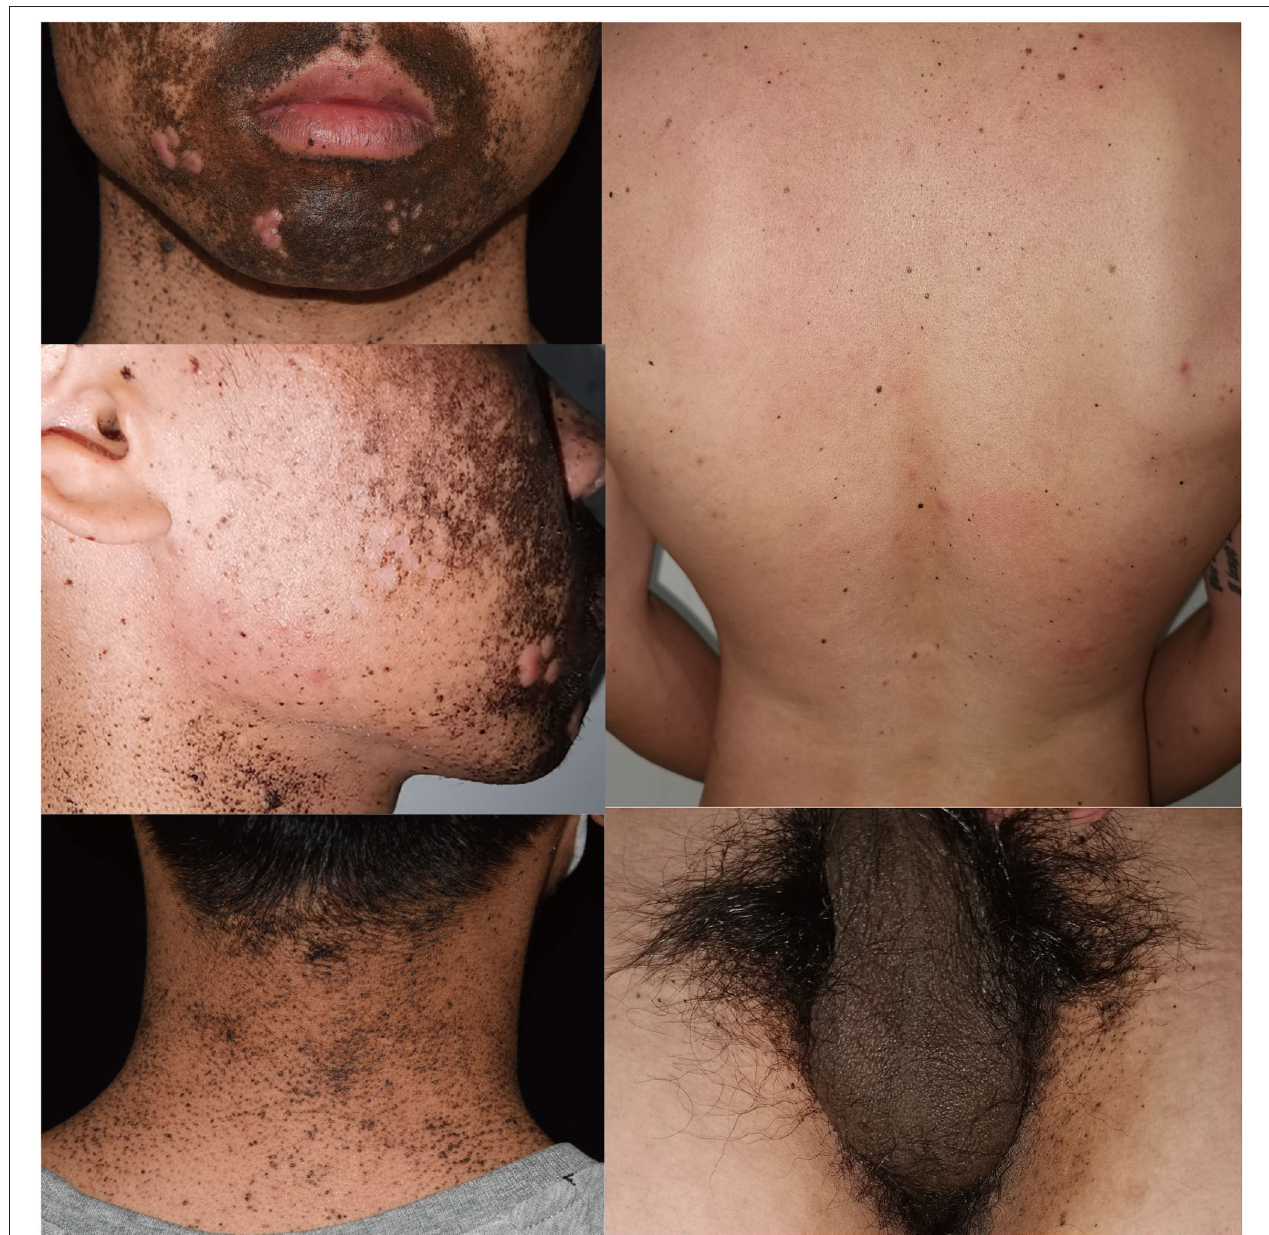
FIGURE 2 | Clinical presentation of the proband showing hyperpigmentation and multiple lentigines on face, neck, back, and inguinal areas.